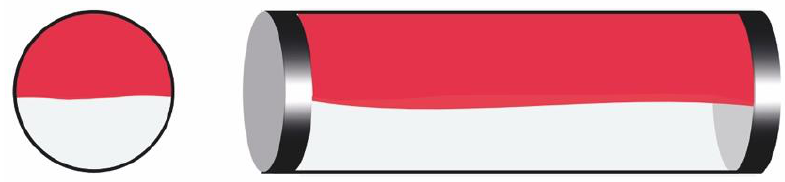
Figure A4. Dispersion of water in oil. [Dw/o]. Stratified flow of water and oil: [O & W]. This flow configuration consists of two dominated, stratified and clear layers of water and oil without the presence of a noticeable dispersed/emulsion layer between the oil and water layers [17].